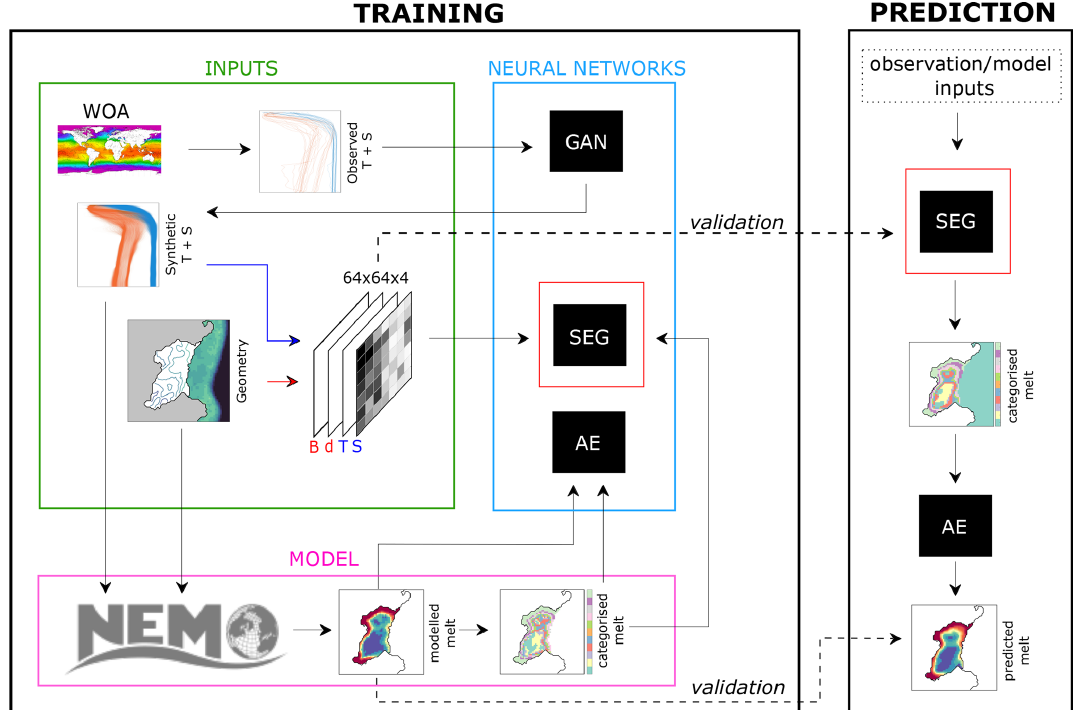
Figure 1. Workflow diagram for the proposed deep learning framework, split into training and prediction. Synthetic ice-shelf geometries (Sect. 2.3.1) and synthetic temperature and salinity profiles generated from WOA data (Sect. 2.3.2) are used (1) as inputs for the NEMO model which predicts a melt rate field and (2) to create a four-channel input image for training of the segmentation network. NEMO melt rates are converted into a labelled image, and the segmentation network trains to segment input images that match labelled NEMO output. Separately, the autoencoder network takes the melt rate map and labelled melt rates from NEMO and learns to map between the two. In both of these networks, ∼ 18% of inputs and NEMO melt rates are withheld to form the test and validation sets. Once the networks are trained, melt rate prediction proceeds by passing input images to the segmentation net and the resulting labelled images to the autoencoder, leading to a melt rate field. Note that the GAN is only used for generation of input fields and not needed for melt rate prediction, as described in Sect. 2.3 and Appendix